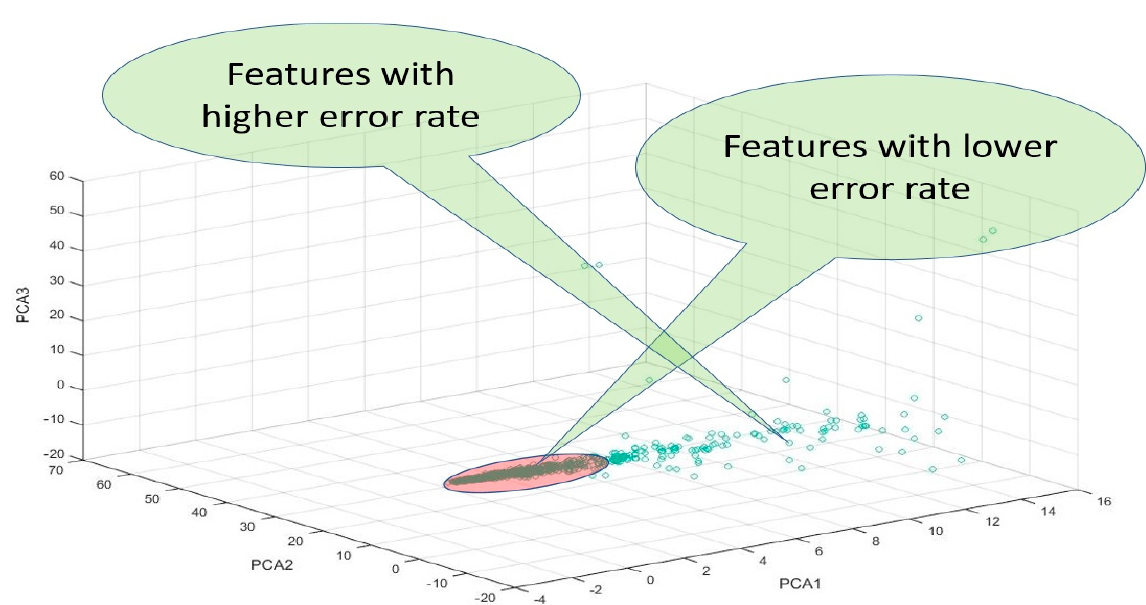
Figure 6. Stages of Proposed methodology.